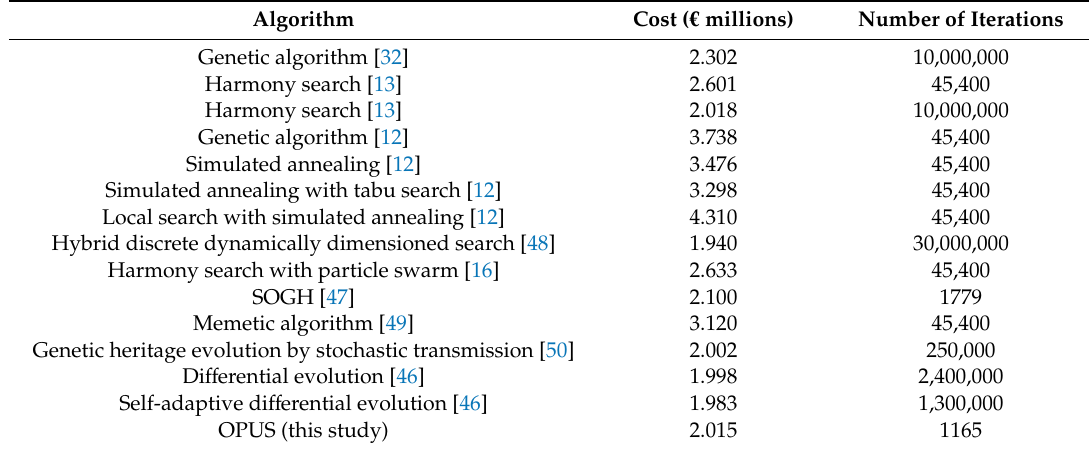
Table 4. Reported costs and number of iterations for the Balerma